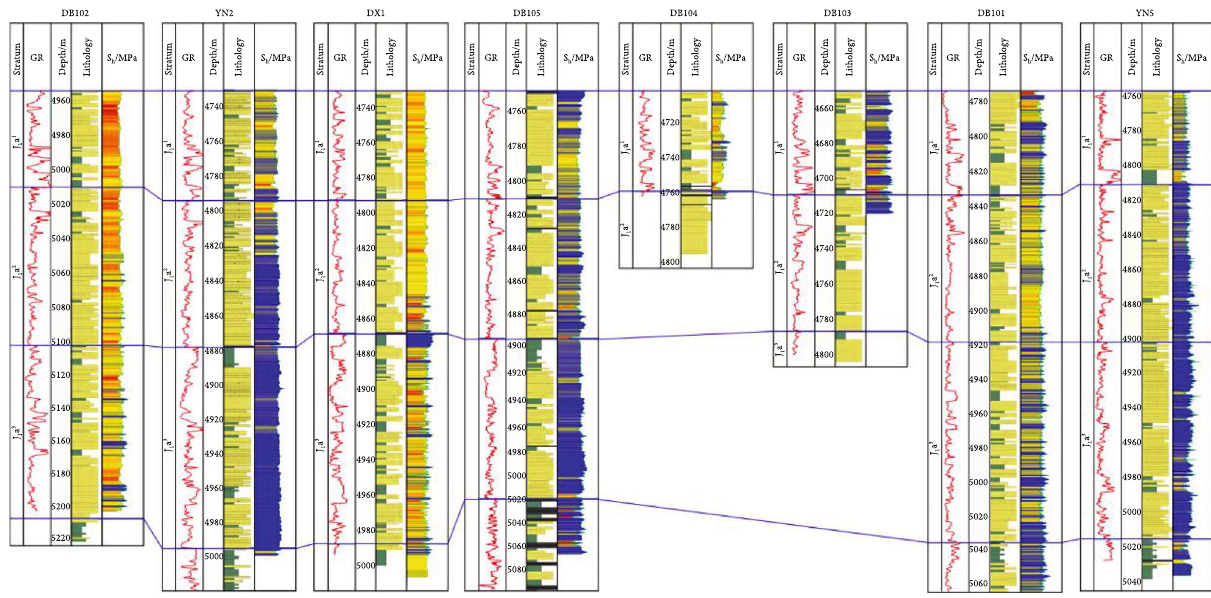
Figure 12: In situ stress pro fi le of typical wells in the Dibei gas